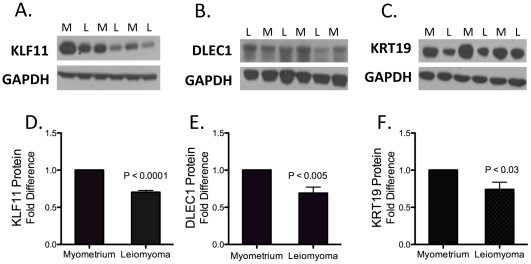
Protein levels of KLF11, DLEC1 and KRT19 in uterine leiomyoma and matched adjacent myometrial tissues.Protein levels of KLF11, DLEC1 and KRT19 in leiomyoma and matched myometrium were analyzed by immunoblotting. (A–C) Western blots are representative of several experiments repeated in at least 6 subjects. (D–F) Protein quantification using ImageJ software shows that there is lower expression of KLF11 (n = 6, P<0.0001), DLEC1 (n = 9, P<0.005) and KRT19 (n = 8, P<0.03) (Student's t-test) in leiomyoma compared to matched adjacent myometrial tissues. GAPDH was used as a loading control. M = myometrial tissue; L = leiomyoma tissue.